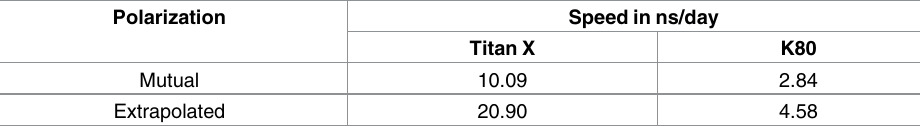
Table 3. Benchmark results for DHFR in explicit solvent using